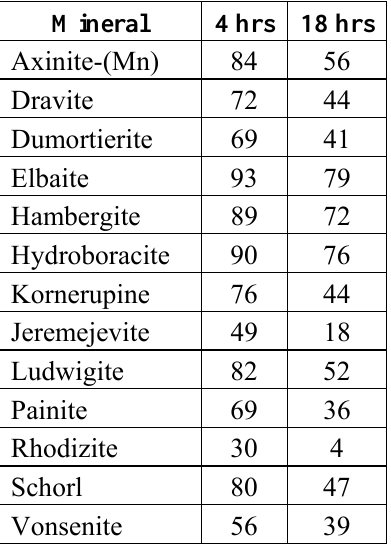
Table 4. RNA retention % on borate minerals. 2 pmoles (30,000 cpm) of P1 RNA were treated with the indicated mineral, as described in Methods. The amount of RNA retained by the mineral at 4 and 18 hrs is reported as percentage of the RNA